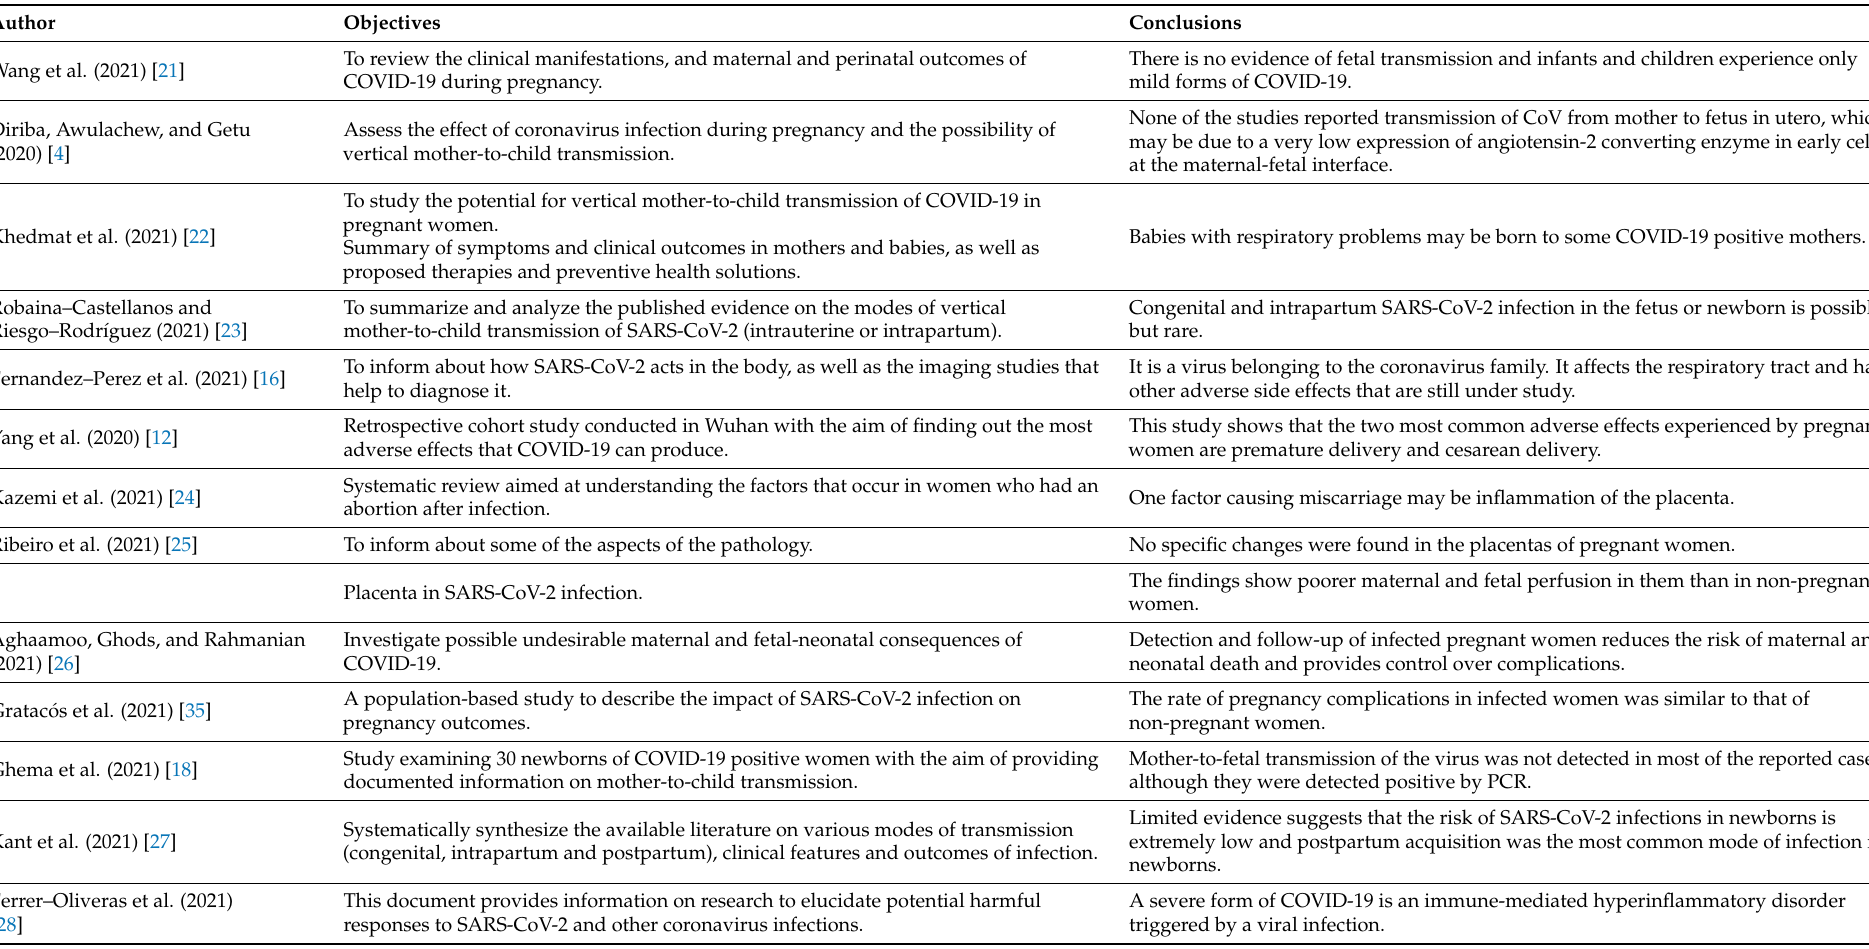
Table 4. Table of